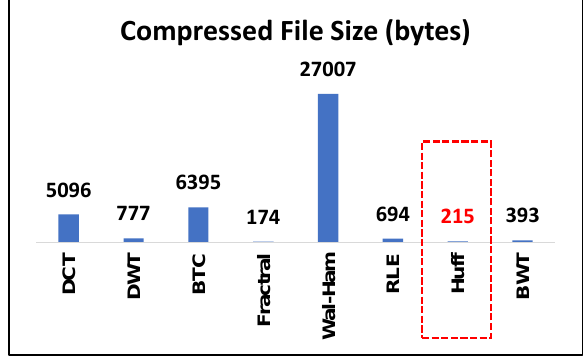
Figure 7. Performance on the basis of compressed file size offered by different image compression algorithms